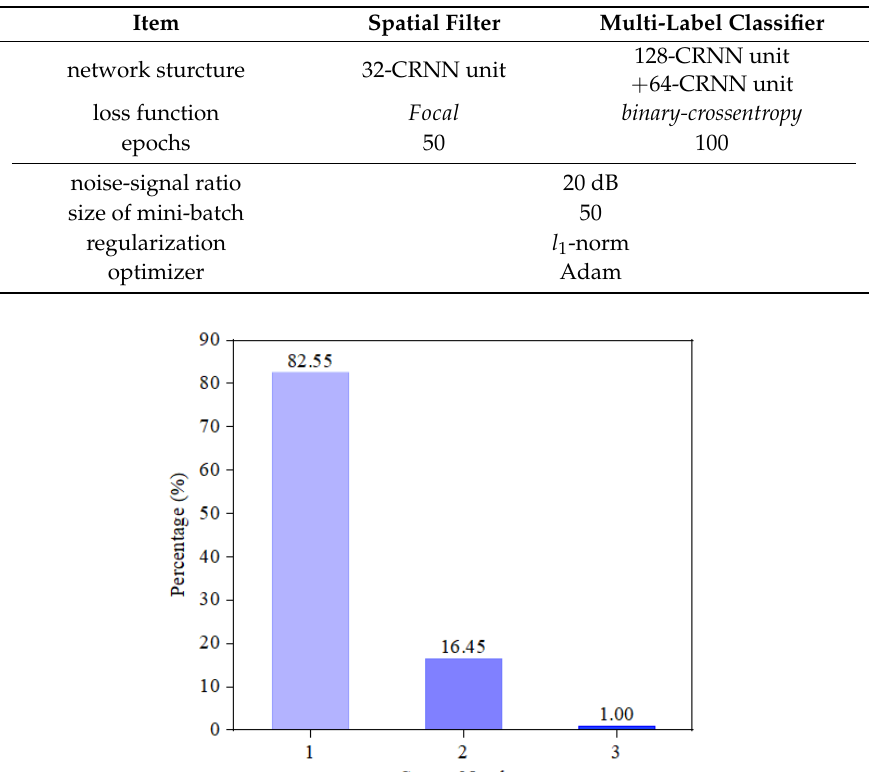
Table 2. Settings for training the spatial filters and multi-label classifiers on Keras.